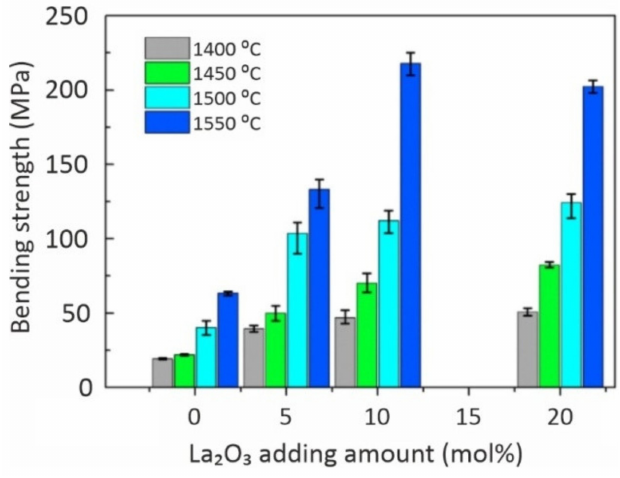
Figure 8. Bending strength versus La 2 O 3 content at differentsintering temperatures